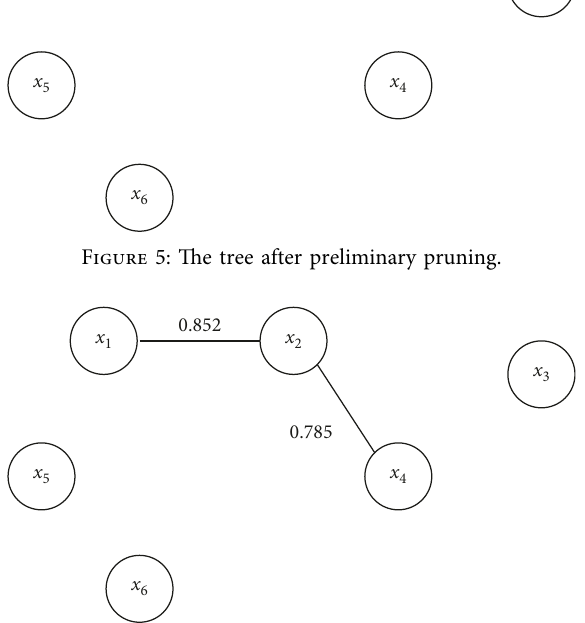
Figure 4: The maximum tree.